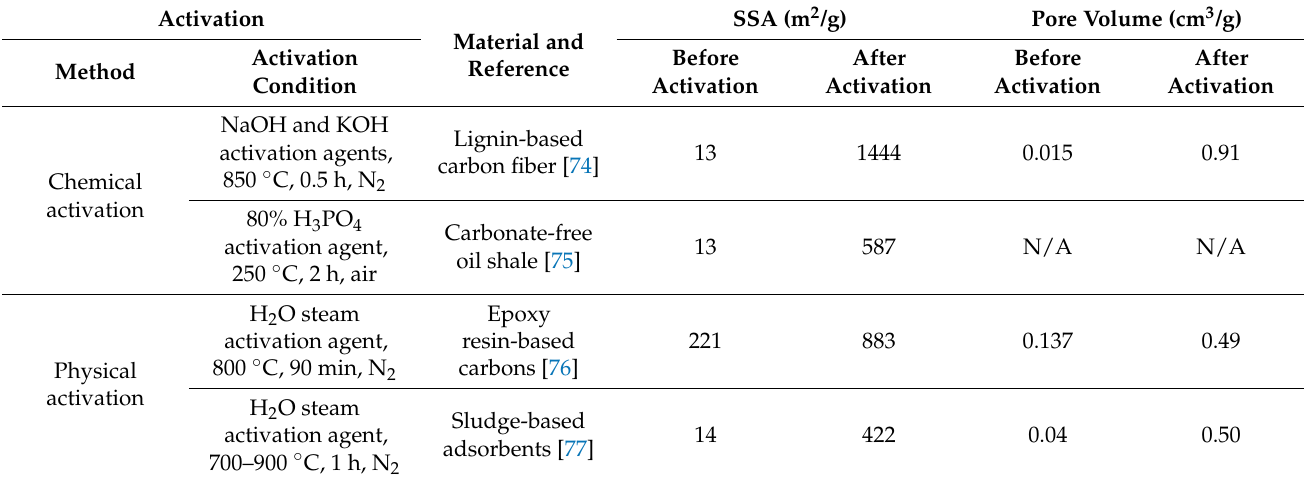
Table 1. Comparison of specific surface area (SSA) and pore volume for unactivated and activated carbon materials.